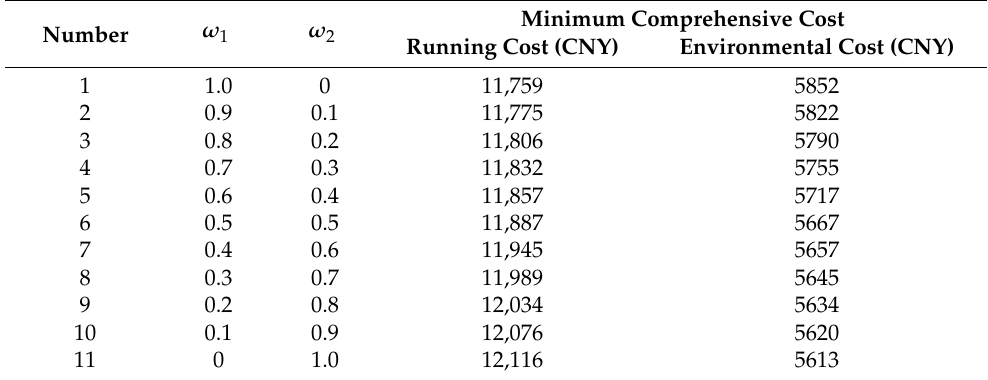
Table 9. Relationship between weight coefficient and objective